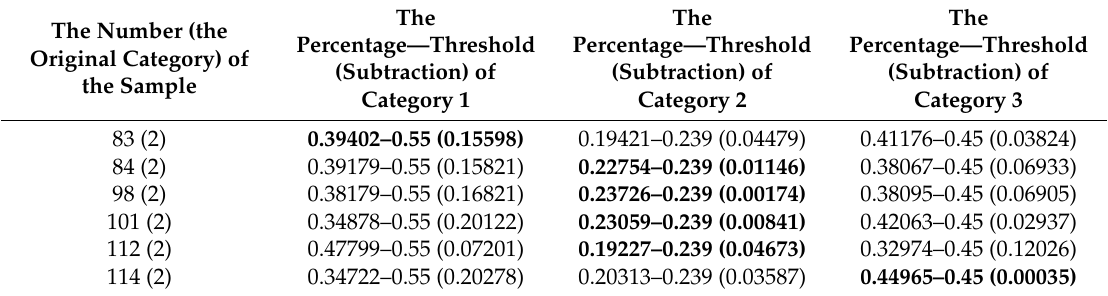
Table 4. The percentage and subtraction of each uncertain Haihe78 corn seed sample.